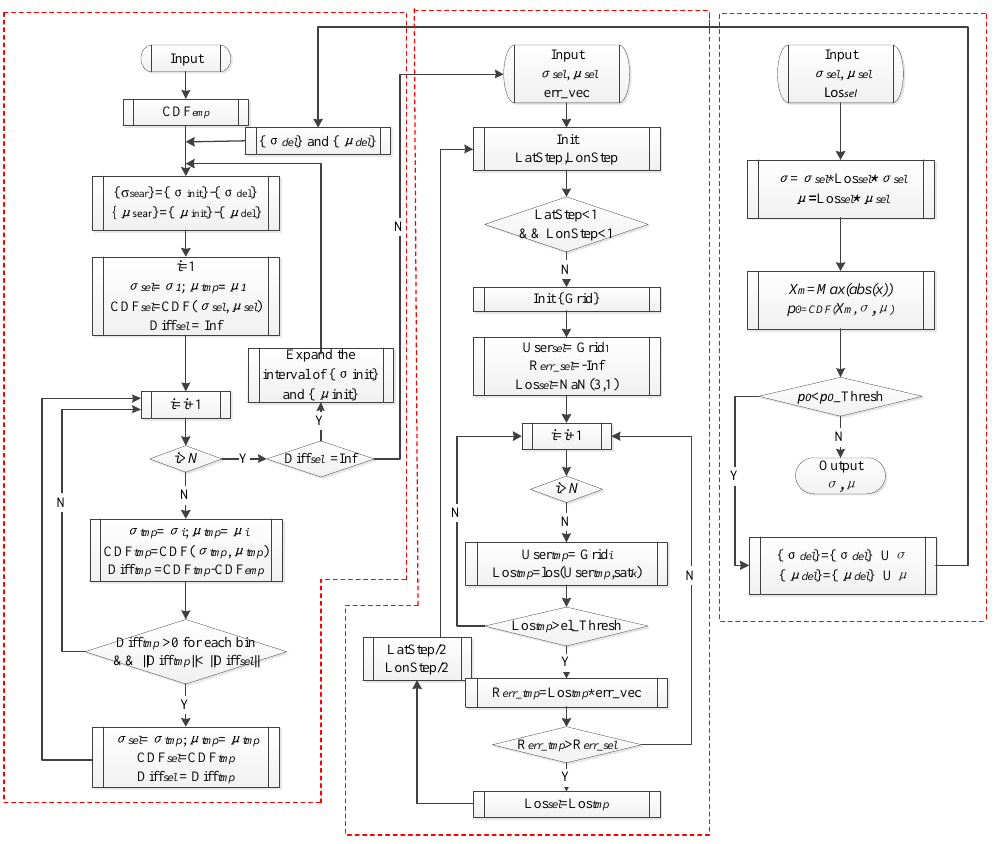
Figure A2. The procedure of parameter estimation. These parts are included: overbounding the error in a single direction, finding the worst user location in the range domain, and hypothesis testing of the results.